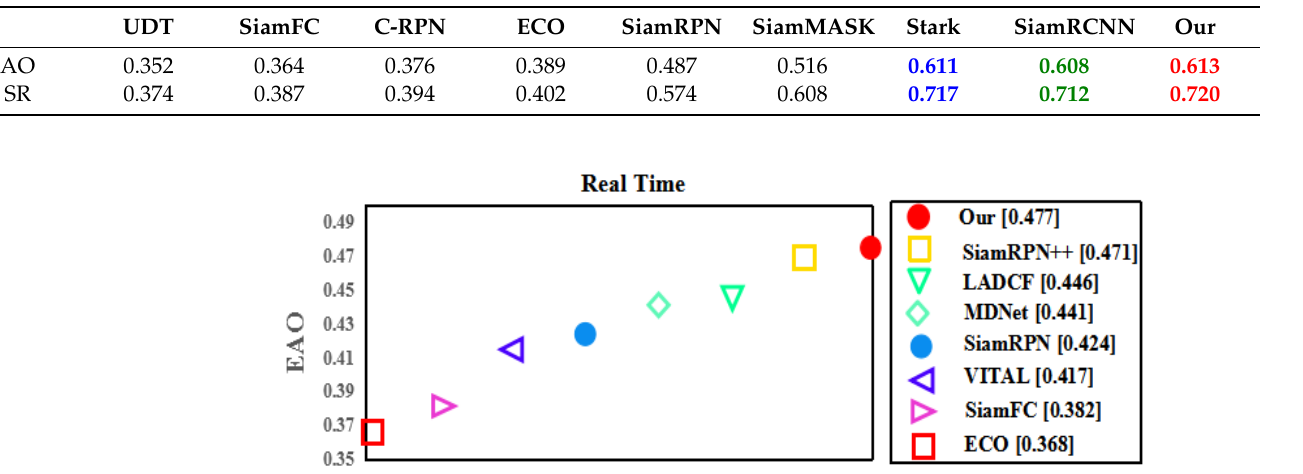
top three tracking effects and the larger the AO and SR, the better the tracking effect).